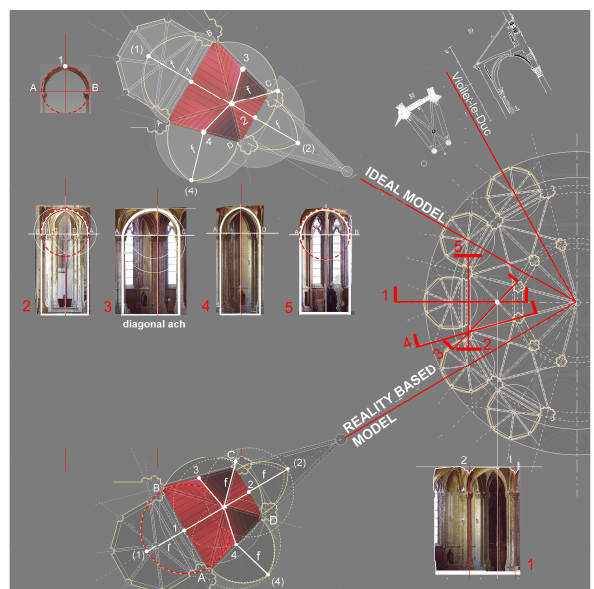
Figure 12 . Comparison between ideal model and reality based model Overlapping the arches generate using the aches method we can see that the arches BA, CD and the diagonal arch DO are perfectly overlapped, but the diagonal arch BO and the perimetral arch DC are very different in relation to the point cloud section.